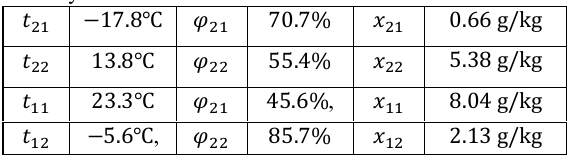
Table 2. Average value of temperature, relative humidity and humidity.